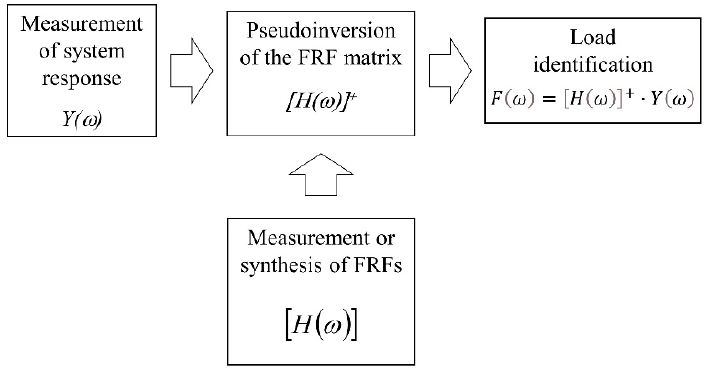
Figure 1. Block diagram of the FRF matrix inversion method.